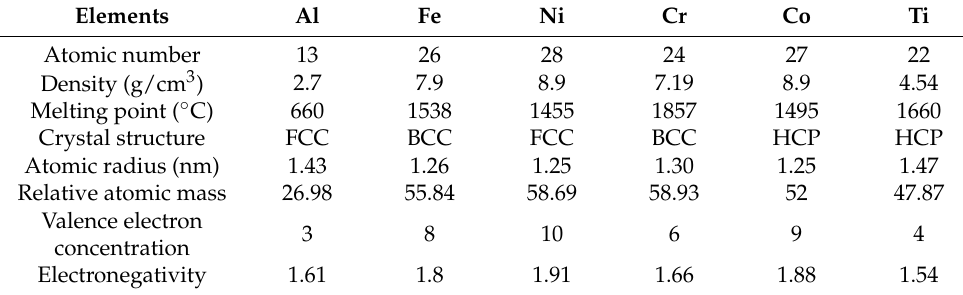
Table 1. The characteristic parameters of each element in high-entropy alloy.